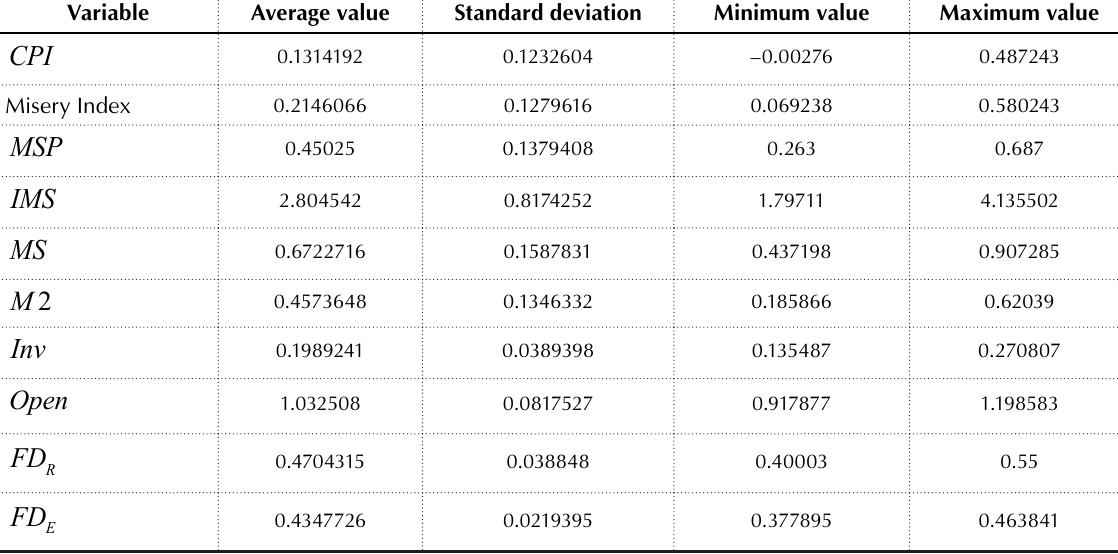
Table 2. Descriptive statistics of the main dependent and explanatory variables of the regression equation (based on our own